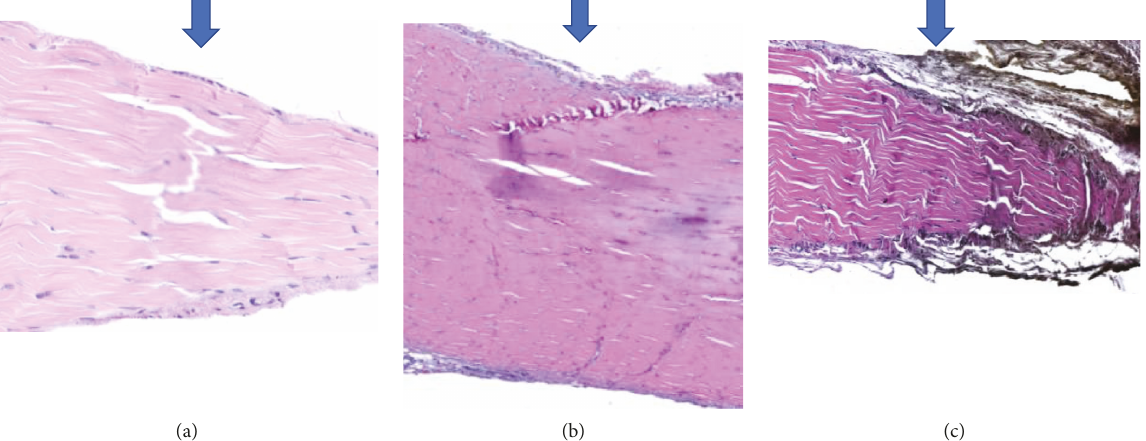
Figure 5: Enlarged images of tissue sections showing an eosin-stained epitendon in one cell layer (normal) or several cell layers (massive fi brosis). Table 7: Analysis of epitendon thicknesses. Table 8: Analysis of tenocyte morphology.